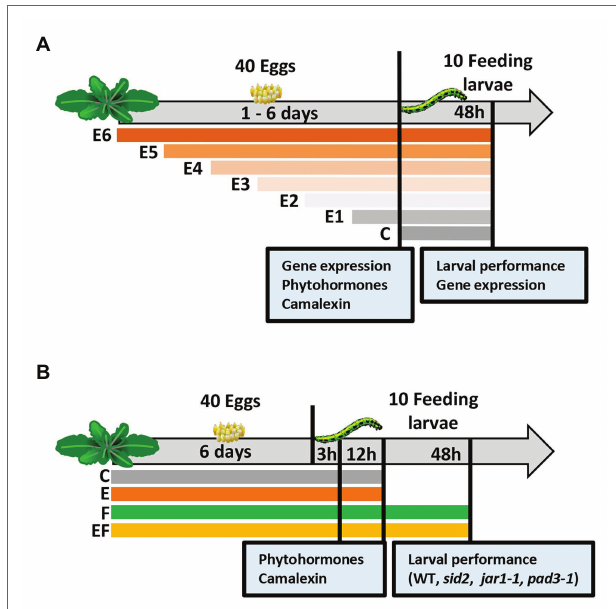
FIGURE 1 | Experimental setups studying timing of priming of Arabidopsis thaliana anti-herbivore defense by prior Pieris brassicae egg deposition and the effects of induced levels of phytohormones and camalexin on larval performance. (A) Experimental setup I focusing on the analysis of plant responses to insect eggs and larval feeding in dependence of the time period, for which plants are exposed to eggs: we determined the effect of P. brassicae egg deposition on A. thaliana plant gene expression, phytohormones, and camalexin levels after different egg exposure times: 1 day (E1), 2 days (E2), 3 days (E3), 4 days (E4), 5 days (E5), or 6 days (E6), and after 48 h of larval feedings. In addition, larval biomass and plant